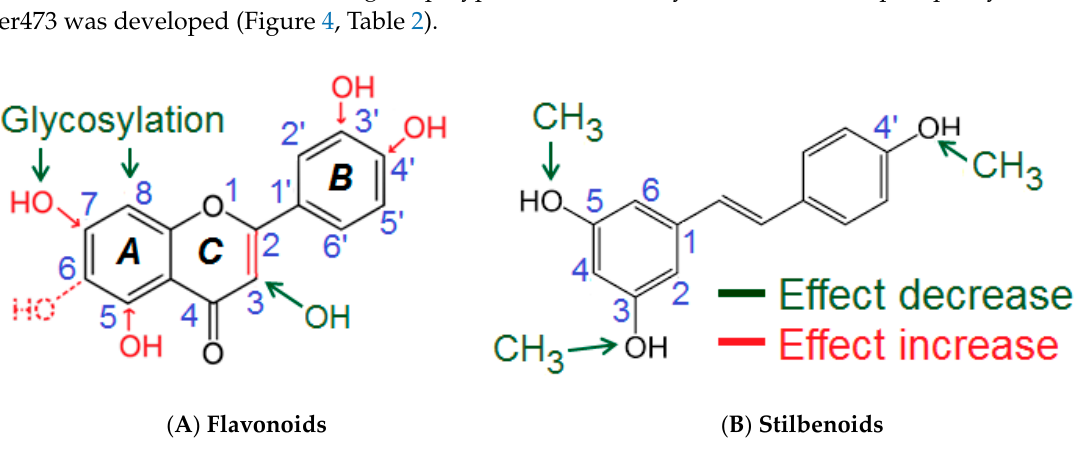
Figure 4. Proposed semi-quantitative structure-activity relationships for flavones / flavon-3-ols ( A ) and stilbenoids ( B ). Structural features decreasing the inhibition of Akt-phosphorylation are marked in green color. Structural characteristics increasing the inhibitory potential of polyphenolic compounds are shown in red. For more details please refer to the text and Table 2.